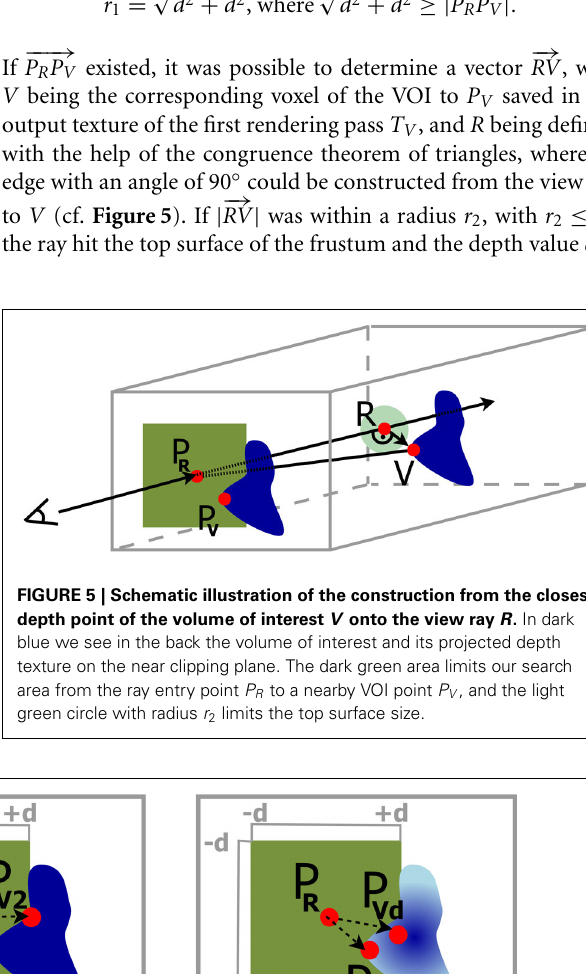
FIGURE 4 | Determination of the local depth value in the cutout. Left: Use as the closest texel of the VOI’s depth texture to the ray entry depth of P V 1 is the most straight aligned texel in relation to P R . Right: point P R . Middle: P V 2